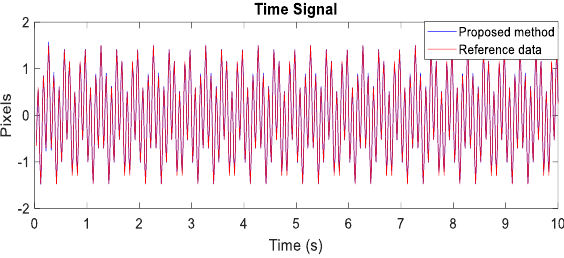
Figure 4. Vibration signal detected by edge-based vibration measuremnet technique